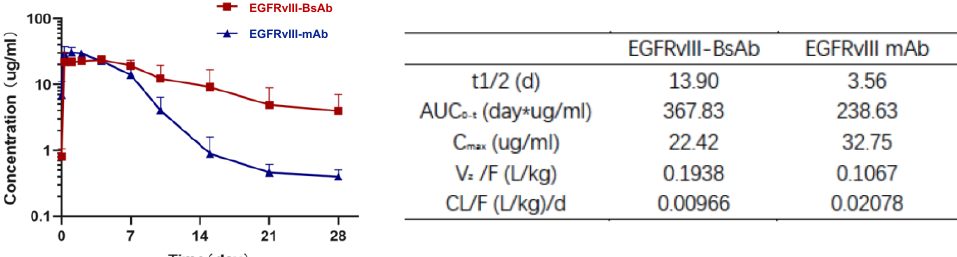
Figure 6. PK analysis of EGFRvIII-BsAb and EGFRvIII mAb in BALB/c mice. Antibody concentration of serum samples at different time points (left figure), and PK parameters analysis (right table).